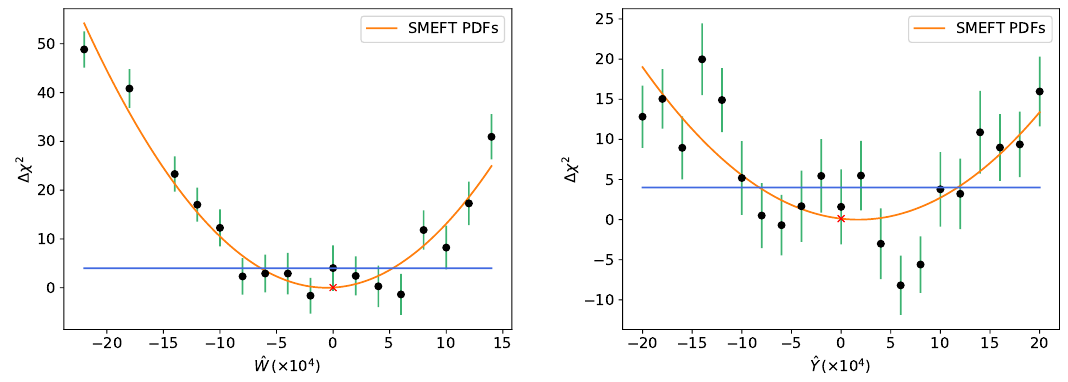
Figure 4 . The values of ∆ χ 2 , eq. (3.12), obtained for the SMEFT PDFs (thus using the χ 2 values) as a function of ˆ W i (left) and ˆ Y i (right panel) in the sampling ranges of eq. (4.1) together with the corresponding parabolic fits. The error bars indicate the finite-size uncertainties and the horizontal line corresponds to the ∆ χ 2 = 4 condition defining the 95% CL intervals. The red cross indicates the SM expectation, ˆ W = ˆ Y = 0